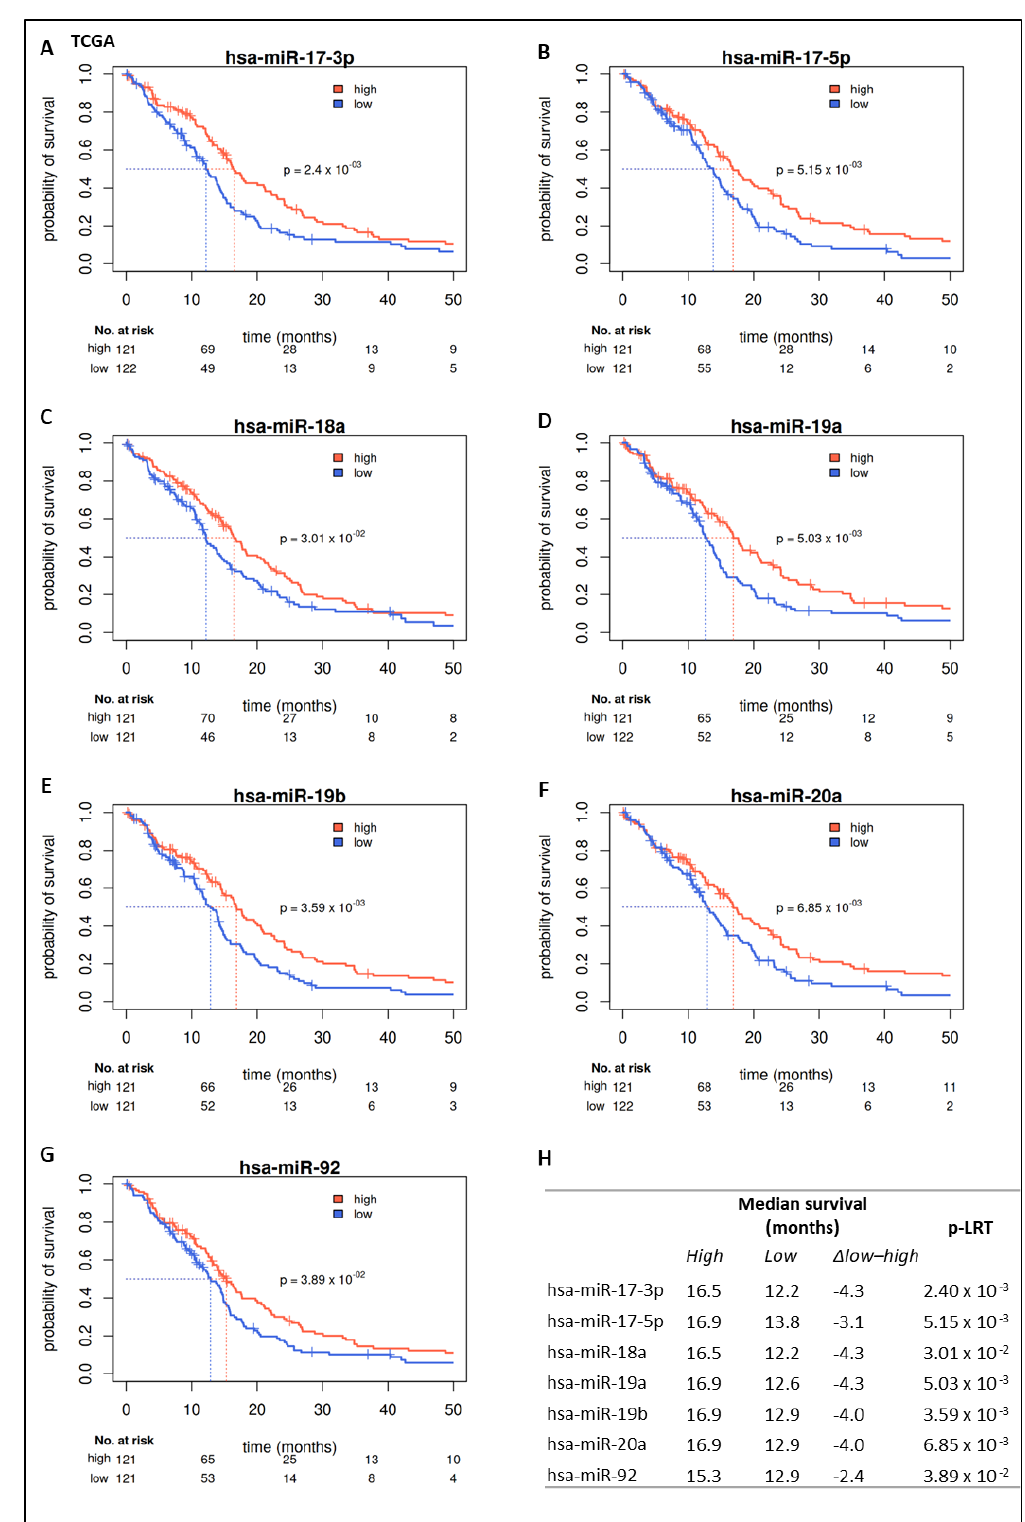
Figure 3. Prognostic value of miR-17-92 family in the TCGA cohort. Kaplan–Meier survival curves for overall survival. High expression of miR-17-3p ( A ), miR-17-5p ( B ), miR-18a ( C ), miR-19a ( D ), miR-19b ( E ), miR-20a ( F ), and miR-92 ( G ) is associated with shorter OS. Median survival differences and p -values are shown in ( H ) (Kaplan–Meier estimators and likelihood ratio tests for groups of patients with expression below the first vs. above the third